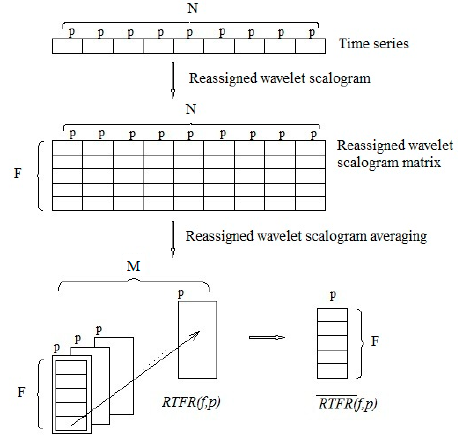
Figure 10. Multi-scales synchronous averaging of reassigned wavelet scalogram.